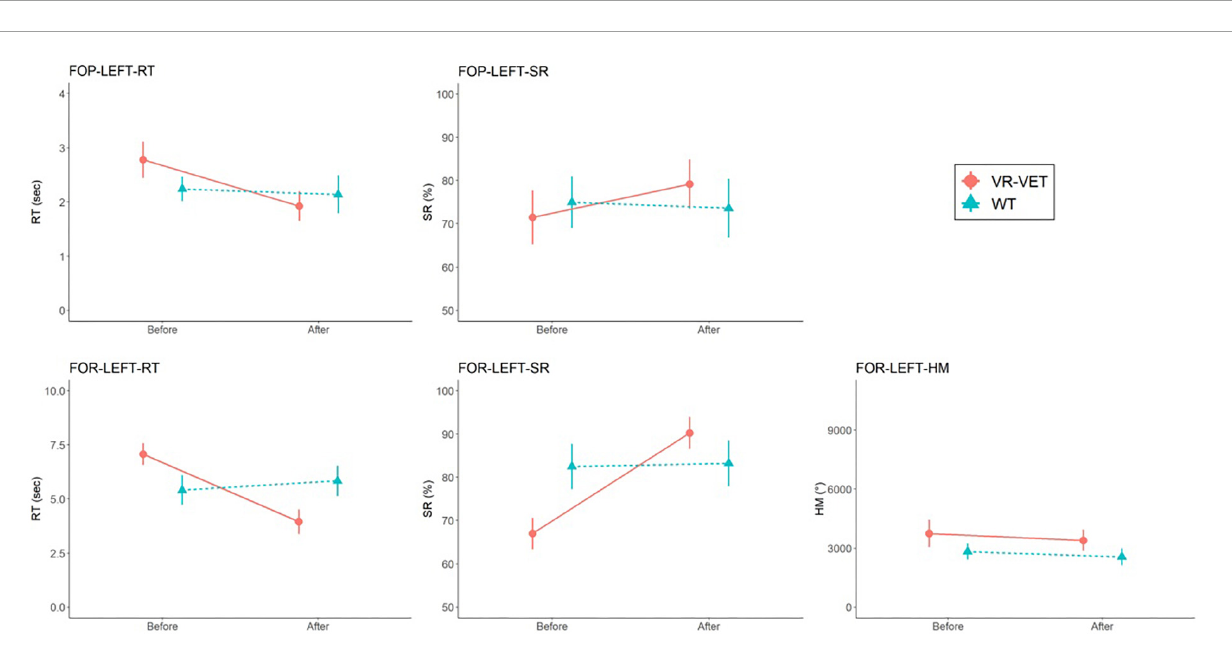
FIGURE4 Comparisons of FOPR test in the left hemispace between VR-VET and waiting. FOP, field of perception; FOR, field of regard; RT, response time; SR, success rate; HM, head movement; VR-VET, virtual reality-visual exploration therapy.